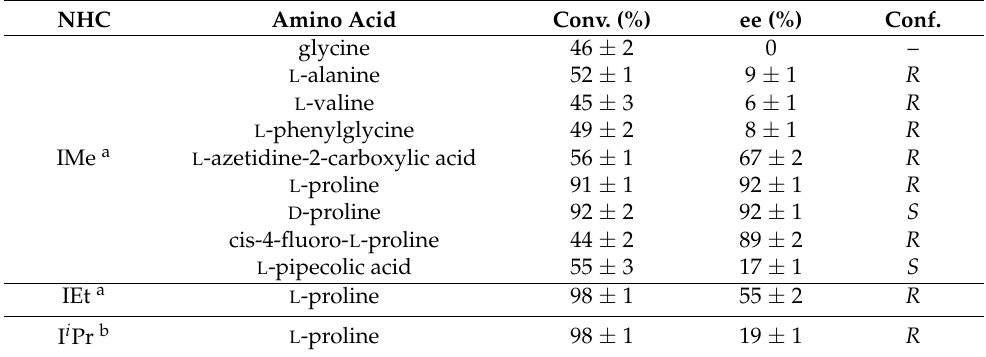
Table 5. Catalyst scope for ATH of acetophenone using the optimized catalytic conditions. Error values are representative of the absolute mean residual from three independent trials. NHC Amino Acid Conv. (%) ee (%)